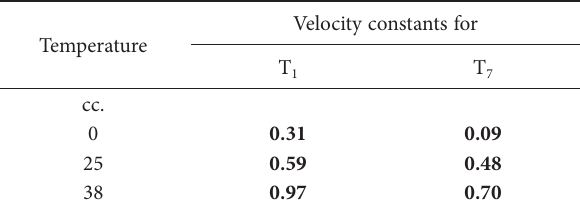
Table III. The Average Velocity Constants for Inactivation of T 1 and T 7 at 0°, 25°, and 38°C.